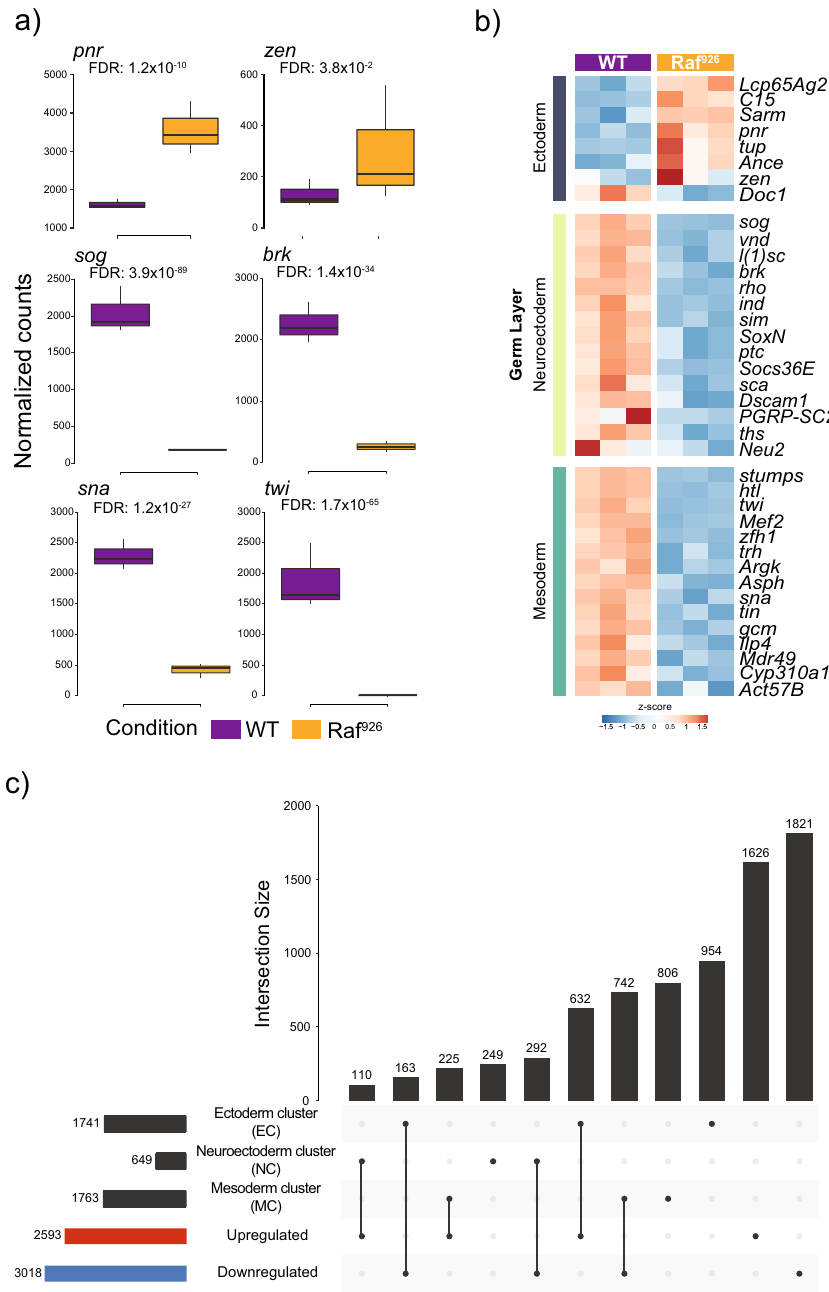
Figure 3. Comparison of expression changes in observed Raf 926 mutants with key germ layer marker genes. ( A ) Expression profiles of key germ layer marker genes in WT and Raf 926 mutant embryos. ( B ) Raf 926 mutants show upregulation of ectoderm marker genes, along with downregulation of neuroectoderm and mesoderm marker genes. ( C ) Upset plot showing the overlap between differentially expressed genes in Raf 926 mutant with clusters of gene expression changes observed after generating embryos with only one germ layer after perturbing the Toll pathway (see S. Fig.